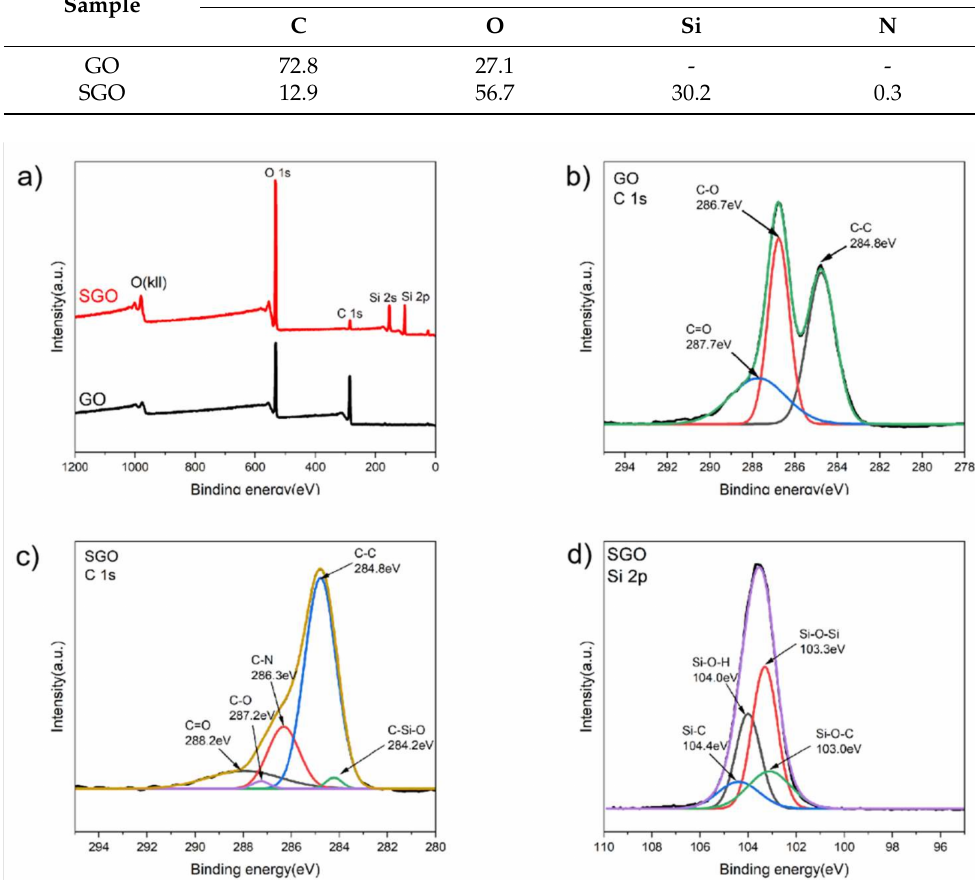
Figure 8. ( a ) XPS wide scan of GO and SGO. XPS C1s spectra of ( b ) GO and ( c ) SGO. ( d ) XPS Si2p spectra of